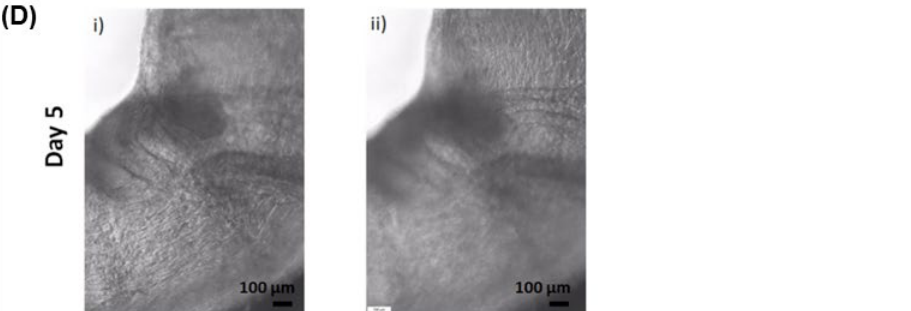
Figure 2. Viability and images of TEBVs with human umbilical vein endothelial cells (HUVEC) and human aortic smooth muscle cells (HASMC) in co-culture. ( A ) Live/dead assay performed on TEBV containing HUVEC and HASMCs in co-culture at 24 h after extrusion (live cells in green and dead cells in red). ( B ) First cells spreading after 2 h of TEBV culture. On the right are presented magnifications at two different plans with red arrows indicating stretched cells. ( C ) Practically all cells were lengthened within 2 days of TEBV culture. On the right are magnifications at two different plans. ( D ) TEBVs started to blend from day 5 at different focus, showing cells on top (i) and cells at the bottom of the TEBV (ii). Images from two different plans.